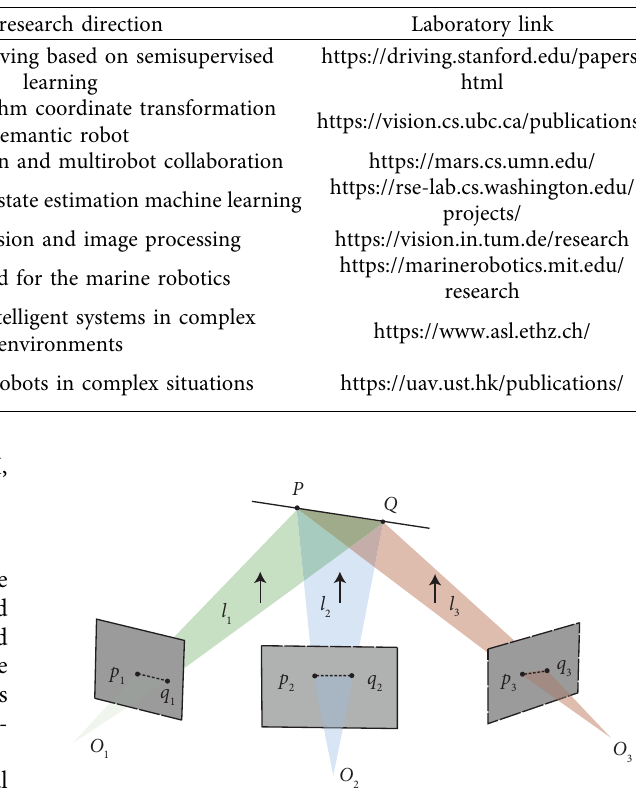
Table 3: Top research institutes.